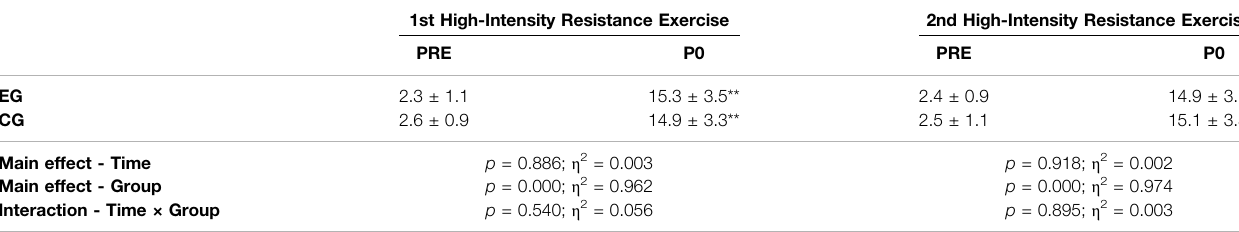
TABLE 3 | Comparison of blood lactate before and after high-intensity resistance exercise test (mmol/L). 1st High-Intensity Resistance